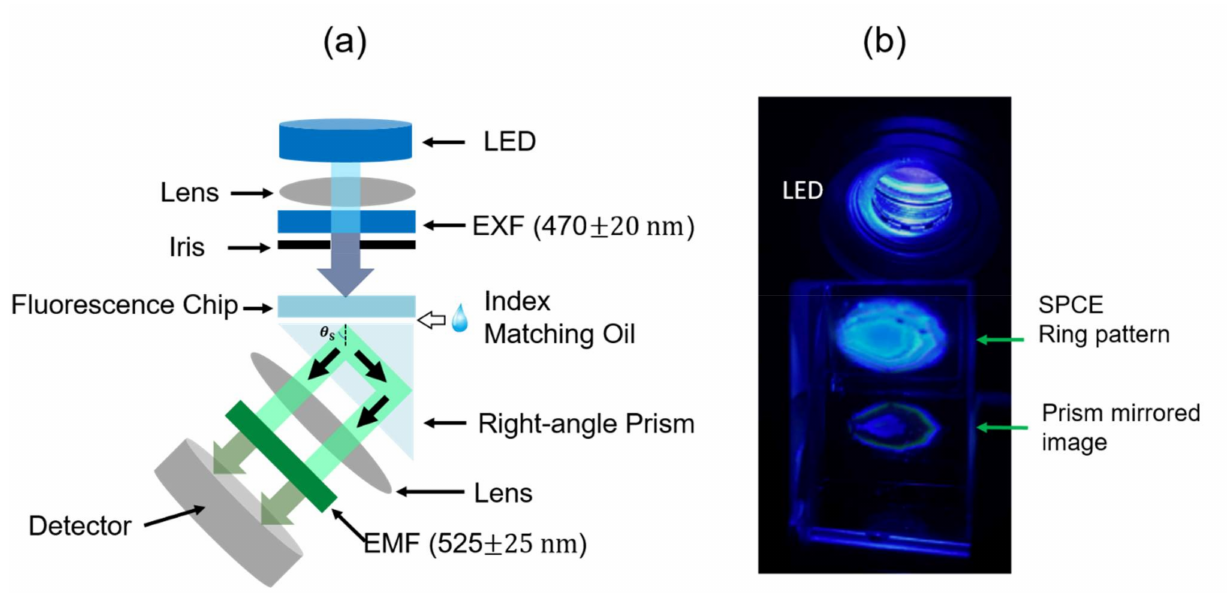
Figure 3. ( a ) Schematic of a setup for fluorescence detection. (EXF: excitation filter, EMF: emission filter, θ s : the angle for SPCE). ( b ) A photo of the ring patterns of emission coupled into the prism, taken from the PMT position at an angle tilted to face the prism base surface. The ring pattern image mirrored from the prism side is seen below the main ring